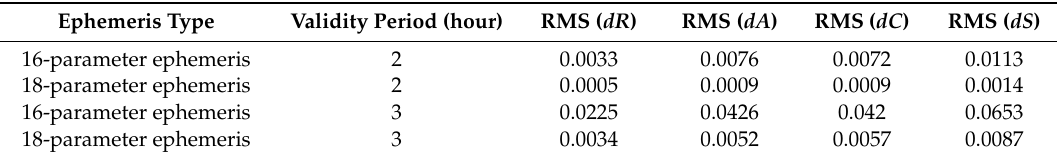
Figure 3. The errors of 18-parameter ephemeris and 16-parameter ephemeris fitting precise orbits (18EphFit and 16EphFit) during the 3 h validity period for the satellite of PRN 3 starting from UTC 2017 / 07 / 05 00:00:00. Table 1. Root mean square (RMS) of the 18-parameter ephemeris and 16-parameter ephemeris fitting errors from all Global Position System (GPS) satellites over two